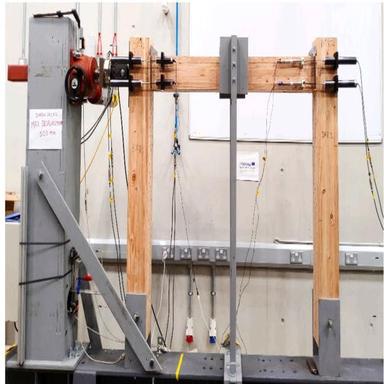
Portal frame test set-up.